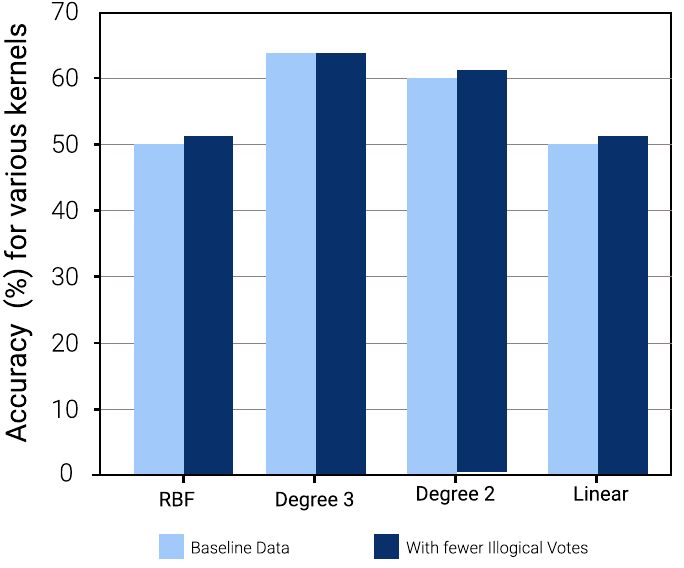
Figure 7. Impact of Illogical Votes (TSV → TPV